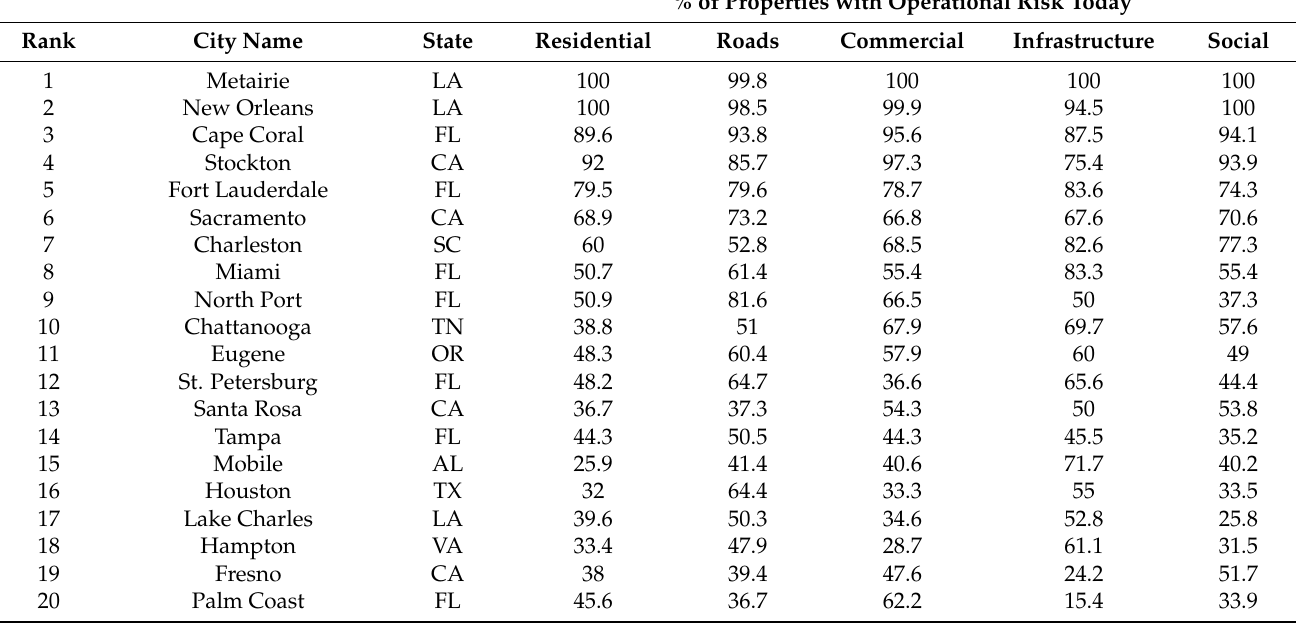
Table 4. Top 20 “most at risk” cities in the U.S. % of Properties with Operational Risk